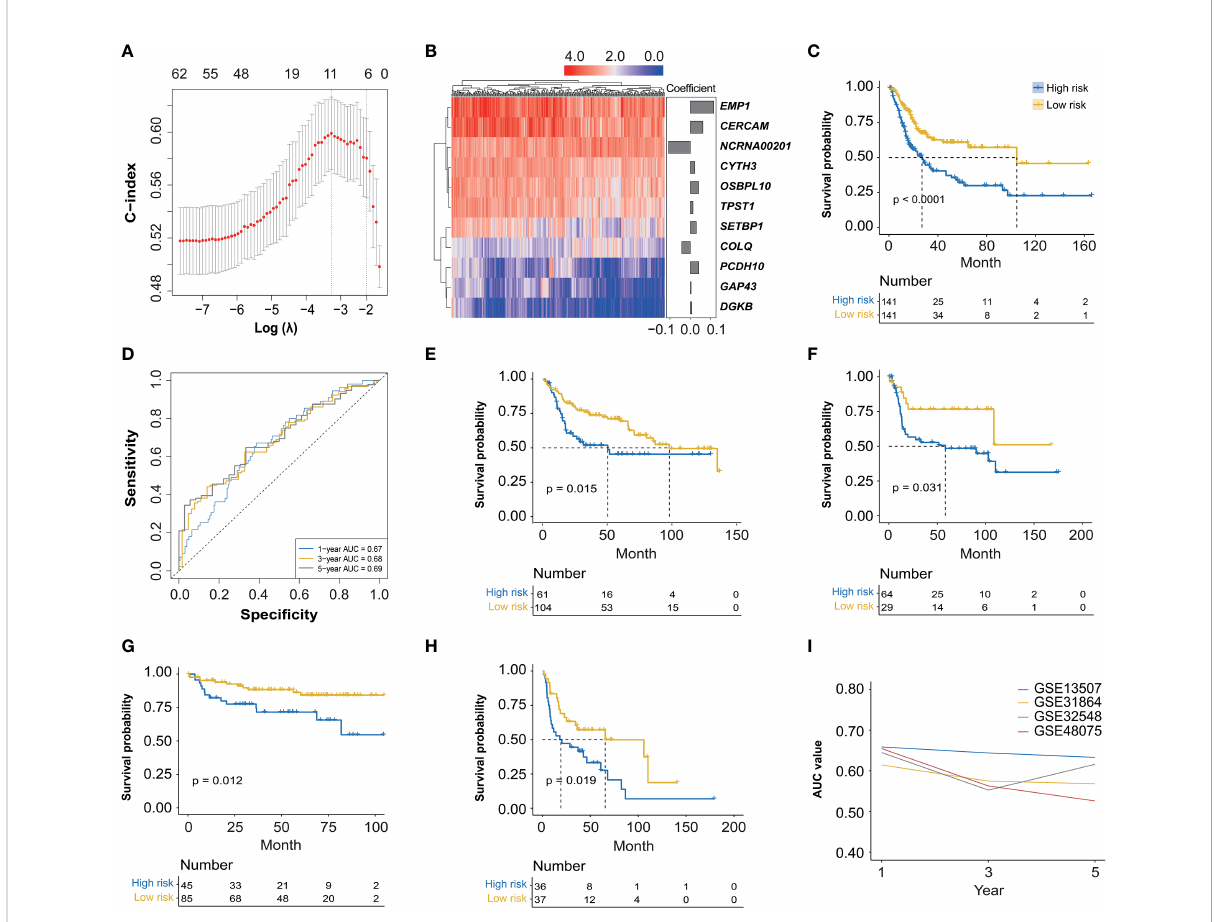
FIGURE 3 The construction and validation of a novel FGFR3 alteration-related gene (FARG) signature. (A) A total of 11 FARGs were involved in the prognostic signature by the least absolute shrinkage and selection operator (LASSO) Cox regression analysis. (B) The heatmap of these 11 FARGs ’ expression among BC patients and their coef fi cients were exhibited. (C) The Kaplan – Meier curve analysis for high- and low-risk BC patients, which were divided by the median value of the FARG score. (D) The receiver operating characteristic (ROC) curve analysis for evaluation of the novel constructed FARG signature. (E – H) The FARG signature was further validated in four independent cohorts: GSE13507 (E) , GSE31684 (F) , GSE32548 (G) , and GSE48075 (H) . (I) The area under ROC curve (AUC) values at 1-, 3-, and 5-year OS further veri fi ed the good performance of the FARG signature in prognosis